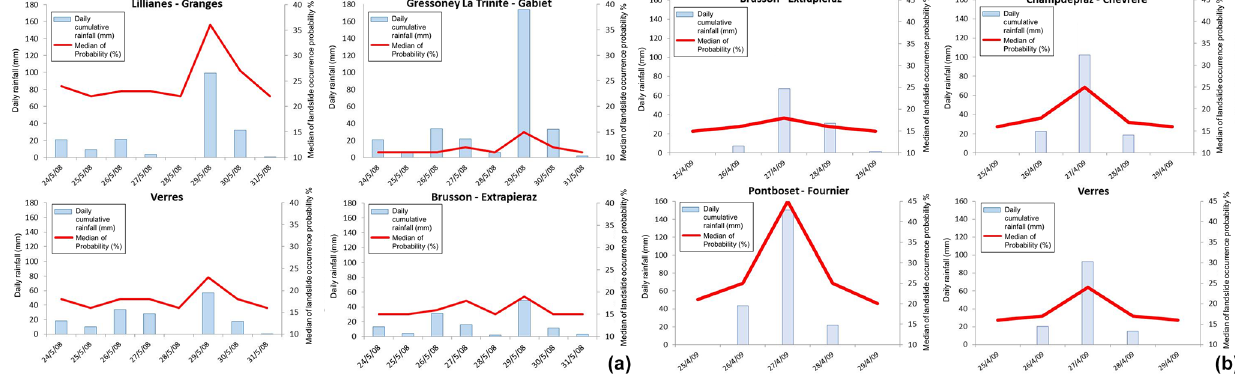
Figure 10. Correlation graphs between the daily cumulative rainfall and the median of the landslide occurrence probability for both